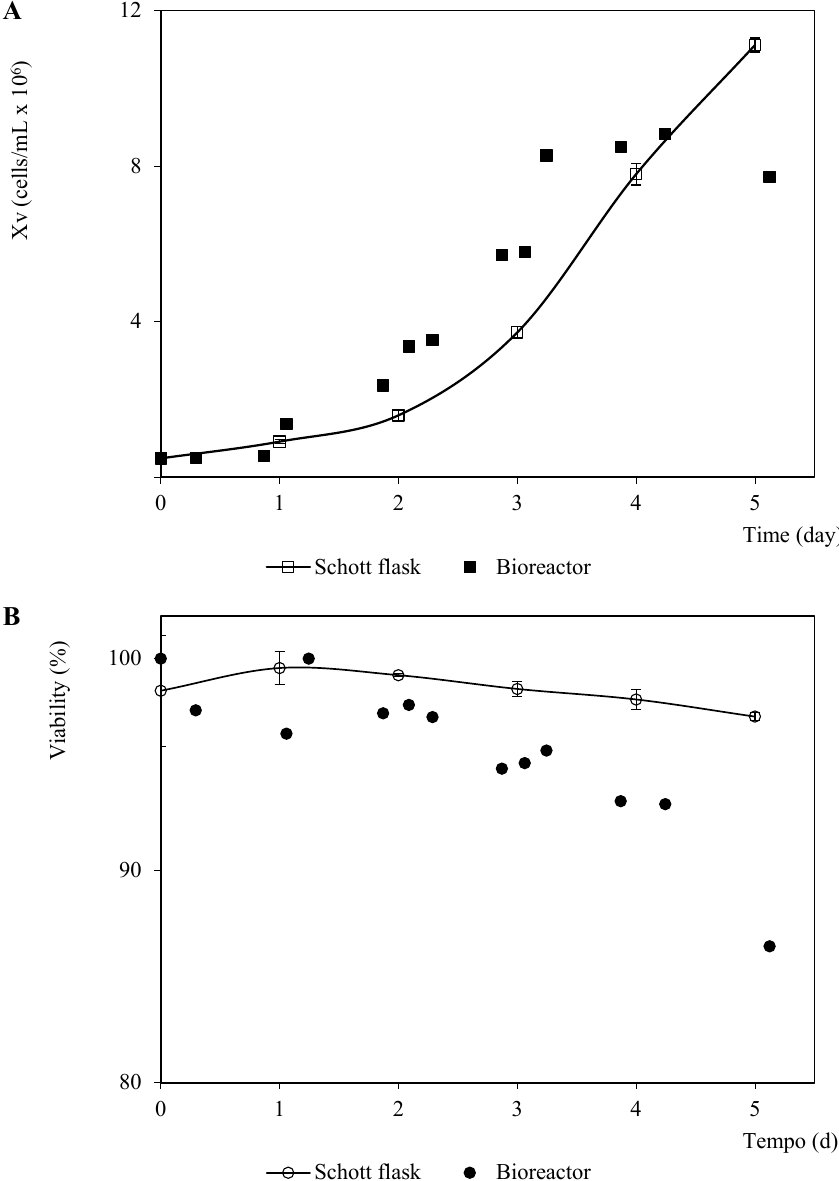
Figure 1. Patterns of viable cell density and viability corresponding to Sf9 cells in SF900 III culture medium in Schott flask and bioreactor. ( A ) Viable cell density pattern. ( B ) Viability pattern. The points and error bars from the Schott flask assays represent the average and the standard deviation of three repetitions,